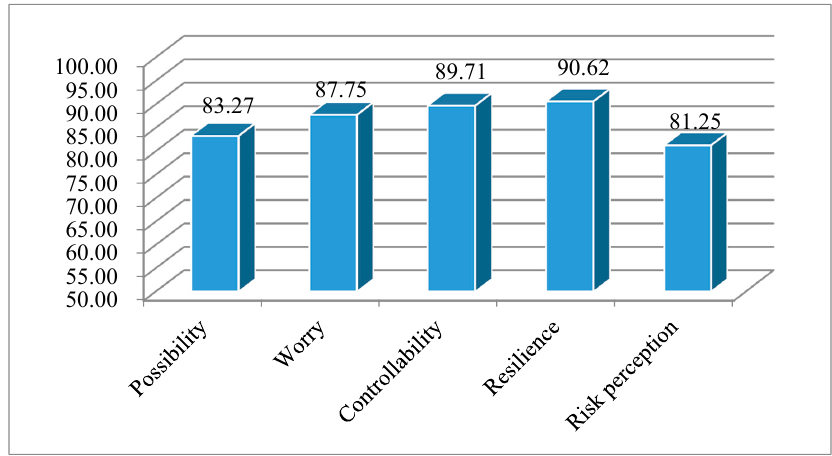
Figure 3. Scores of rural households’ risk perception.